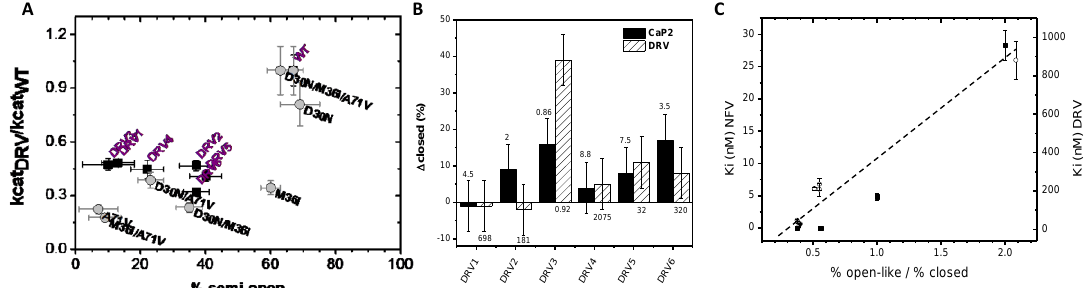
Figure6. ( A )Ratioofkcat DRV / kcat WT foreachconstructversusthefractionaloccupancyofthesemi-open Figure 6. ( A ) Ratio of kcat DRV /kcat WT for each construct versus the fractional occupancy of the semi- conformation in unbound HIV-1 PR. Data are included for the six DRV constructs (black squares) as well open conformation in unbound HIV-1 PR. Data are included for the six DRV constructs (black as for a series of accumulated mutations in response to nelfinavir (NLV) (gray circles)–taken from [14]. squares) as well as for a series of accumulated mutations in response to nelfinavir (NLV) (gray ( B ) Plot of the change in the closed population ( ∆ closed% = closed (inhibitor)–closed (unbound)) for Figure 6. ( A ) Ratio of kcat DRV /kcat WT for each construct versus the fractional occupancy of the semi- circles) – taken from [14]. ( B ) Plot of the change in the closed population (∆closed% = closed (inhibitor)– each DRV construct with solid bars being the non-hydrolysable CaP2 inhibitor and slashed bars data for open conformation in unbound HIV-1 PR. Data are included for the six DRV constructs (black closed (unbound)) for each DRV construct with solid bars being the non-hydrolysable CaP2 inhibitor the DRV inhibitor. Numbers above the bar report the fold change in K m values, whereas numbers below squares) as well as for a series of accumulated mutations in response to nelfinavir (NLV) (gray and slashed bars data for the DRV inhibitor. Numbers above the bar report the fold change in K m the bars report the fold change in K i values (data taken from [31]). ( C ) Plot of K i value as a function of circles) – taken from [14]. ( B ) Plot of the change in the closed population (∆closed% = closed (inhibitor)– values, whereas numbers below the bars report the fold change in K i values (data taken from [31]). the fractional occupancy of the ratio of the open-like to closed states for unbound DRV constructs with closed (unbound)) for each DRV construct with solid bars being the non-hydrolysable CaP2 inhibitor ( C ) Plot of K i value as a function of the fractional occupancy of the ratio of the open-like to closed K i (DRV) plotted as solid squares compared to our earlier investigations of NFV-resistant constructs and slashed bars data for the DRV inhibitor. Numbers above the bar report the fold change in K m states for unbound DRV constructs with K i (DRV) plotted as solid squares compared to our earlier to K i (NLV) plotted as open circles. The dashed line is a guide for the eyes showing a linear trend. values, whereas numbers below the bars report the fold change in K i values (data taken from [31]). investigations of NFV-resistant constructs to K i (NLV) plotted as open circles. The dashed line is a The y-axes di ff er for the two data sets and are labeled according to the inhibitor. ( C ) Plot of K i value as a function of the fractional occupancy of the ratio of the open-like to closed guide for the eyes showing a linear trend. The y-axes differ for the two data sets and are labeled states for unbound DRV constructs with K i (DRV) plotted as solid squares compared to our earlier Figure 6B plots for each DRV construct the change in the fractional occupancy of the closed according to the inhibitor. investigations of NFV-resistant constructs to K i (NLV) plotted as open circles. The dashed line is a conformation, ∆ closed, upon the addition of CaP2 or DRV. Numbers on top of the bars reflect the fold guide for the eyes showing a linear trend. The y-axes differ for the two data sets and are labeled change in K m , and those reported below the bars reflect the fold change in K i . As expected, DRV3 has according to the inhibitor. a marked conformational shift in the presence of the inhibitor DRV. Other constructs have trends in